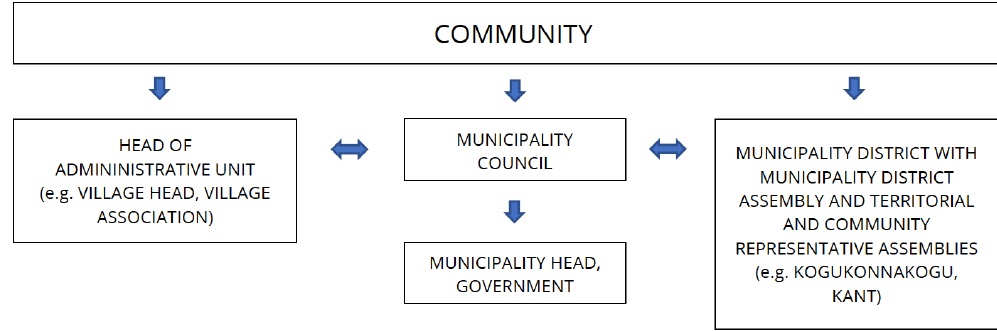
Fig. 2. Decentralisation of municipality with community involvement possibilities (adapted from Lõhmus et al . 2016,